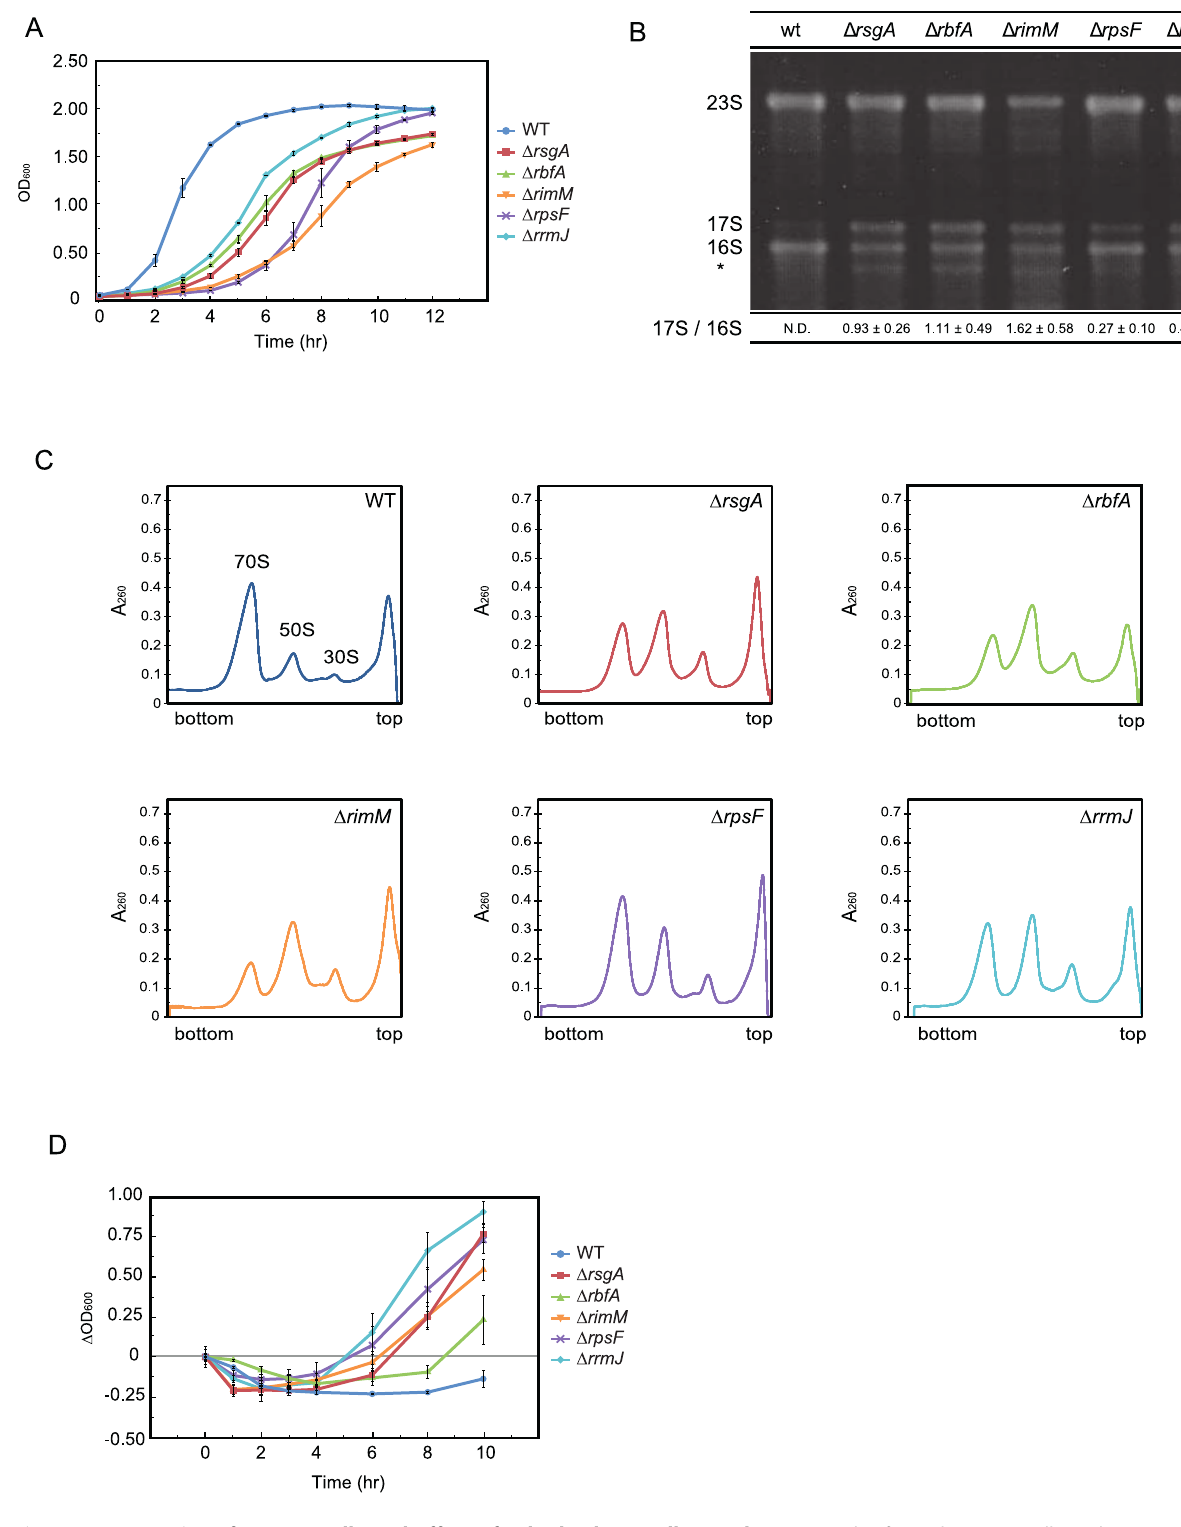
PLOS ONE | www.plosone.org